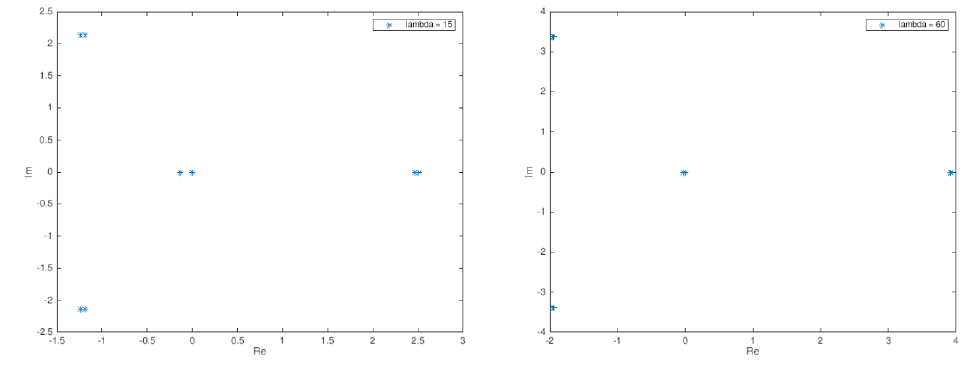
Figure 7. Eigenvalues of the matrix A for λ = 15 and λ = 60.